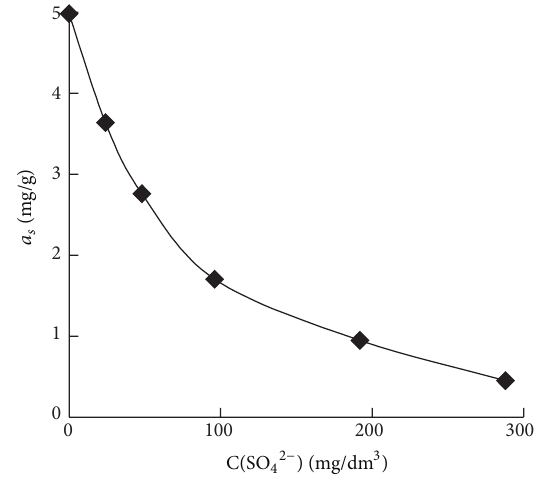
Figure 10: Effects of SO 42− concentration on Cr(VI) sorption on = 5.0 mg/dm 3 , 𝑚 = 0.05 g, and Zn 4 Al 2 O 7 at pH 0 = 5.0. 𝐶 Cr ( VI ) 𝑉 = 50 cm 3